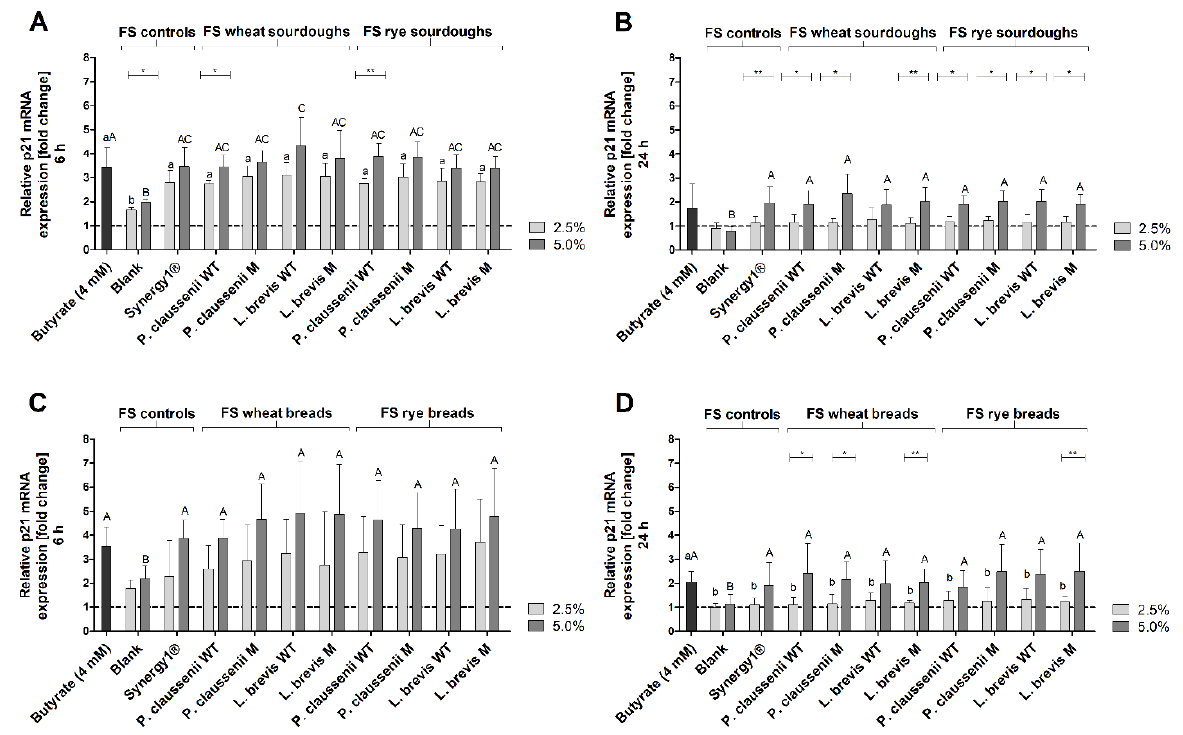
Figure 7. Relative p21 mRNA expression in LT97 cells after treatment with 2.5% and 5% fermentation supernatants (FS) obtained from controls (blank, Synergy1 ® ) and wheat and rye sourdoughs as well as 4 mM butyrate for 6 h ( A ) and 24 h ( B ) and with FS obtained from controls (blank, Synergy1 ® ) and wheat and rye breads as well as 4 mM butyrate for 6 h ( C ) and 24 h ( D ) (mean + SD, n = 4). Results are presented as fold changes based on a medium control, which was set 1 (dashed line).